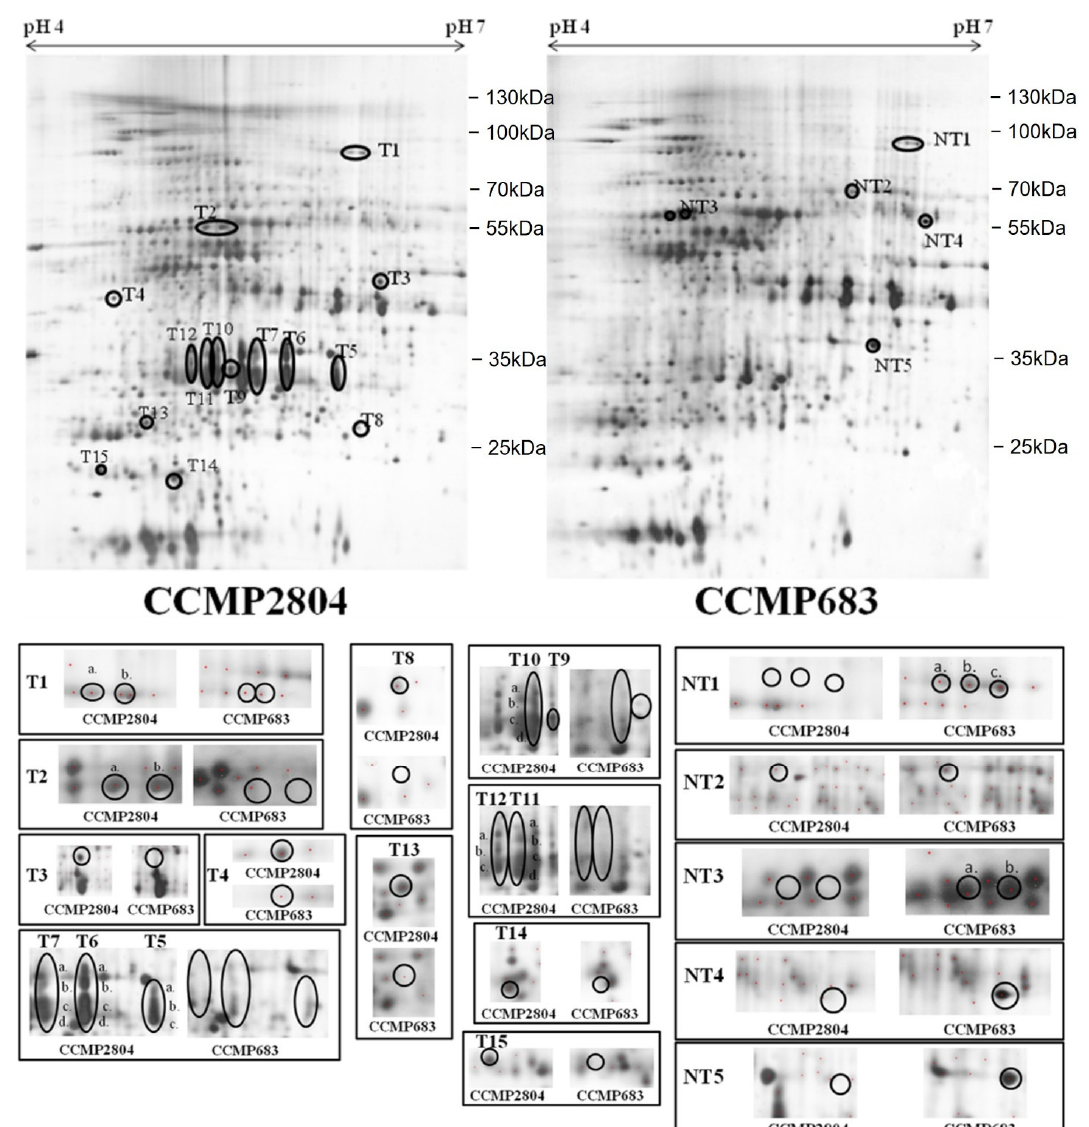
Figure 1. Representative 2-DE profiles of 100 µ g protein extracts from the two strains of P. hoffmanni- anum with normal nutrient supply separated over a pH range of 4–7 and then by 10% SDS-PAGE. Protein visualization was performed with silver stain. The circled spots with initials “T” and “NT” were upregulated in the toxic strain CCMP2804 and non-toxic strain CCMP683 respectively when compared with each other. A side-by-side comparison of each pair of enlarged differential protein spots was included.